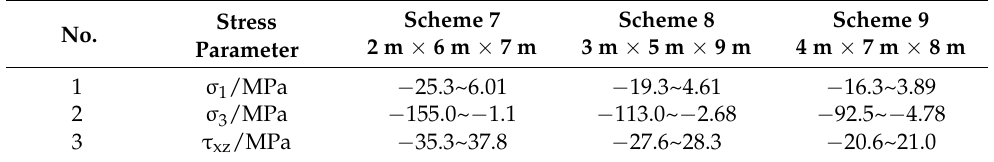
Table 6. Numerical calculation with stope height of 4.5 m.